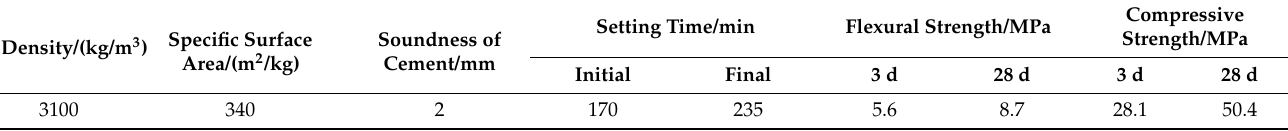
Table 1. Physical properties of P · O 42.5 cement.